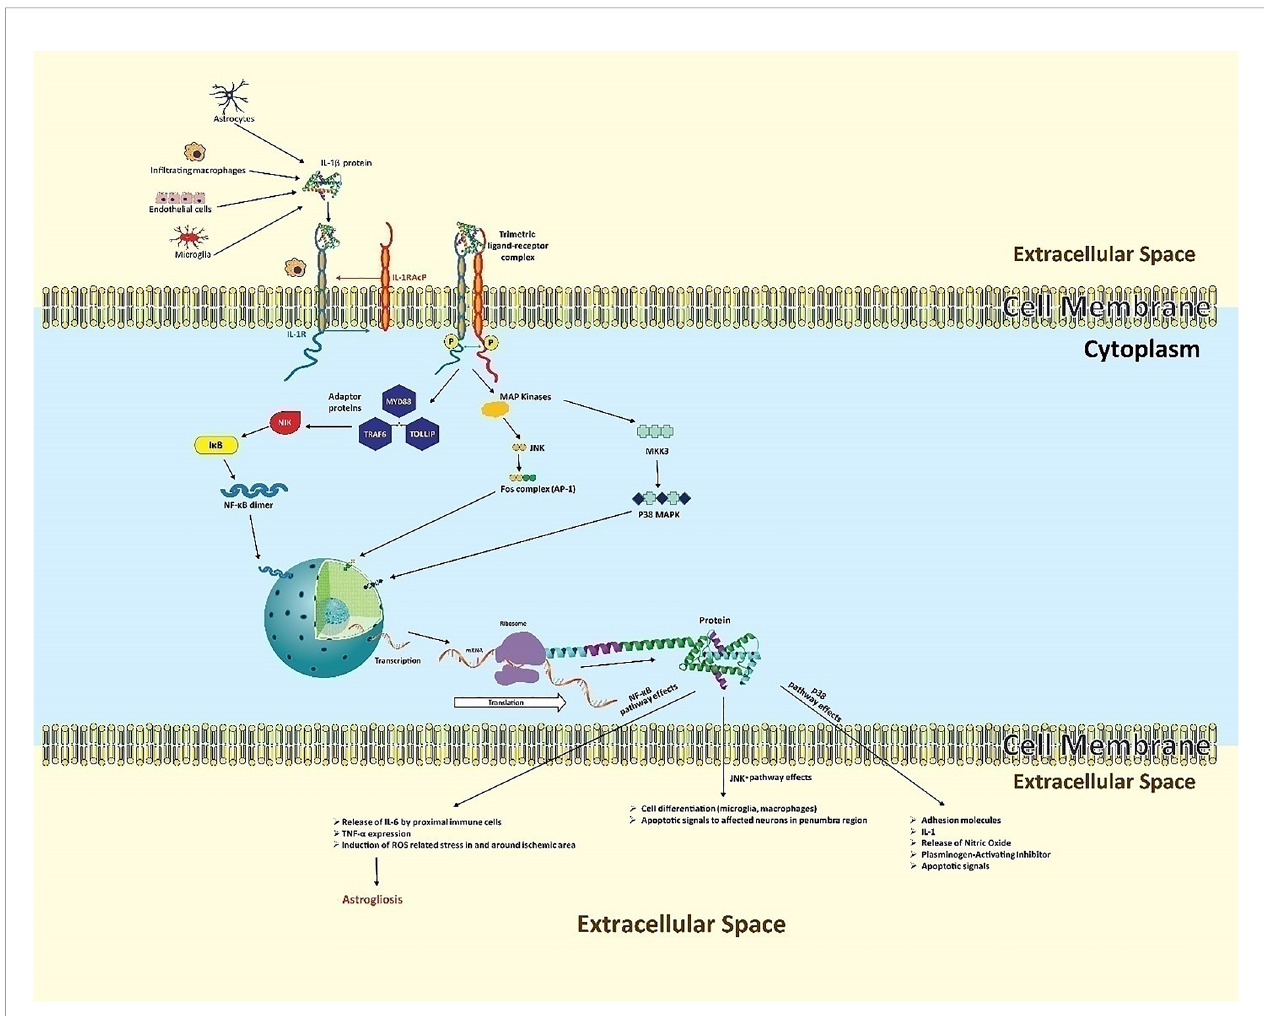
FIGURE 2 | The neuroin fl ammatory cascades of IL-1 b following ischemic insult. Secreted by microvascular endothelial cells, resident microglia, astrocytes, and in fi ltrating macrophages, IL-1 b forms a complex with IL-1R1, aided by IL-1RAcP. This ligand-receptor complex triggers three key neuroin fl ammatory mechanisms. In the NF- k B pathway, ligand-receptor binding results in the cytoplasmic recruitment of three key adaptor proteins: MYD88, TOLLIP, and TRAF6. This leads to the activation of intermediate kinases, particularly NIK, which prevent I k B from inactivating NF- k B, indirectly allowing NF- k B-dimer formation. These dimers of NF- k B function as transcriptional factors, entering the nucleus to induce transcription of IL-1, TNF, and many other genes in various cell types. In the JNK pathway, downstream of the “ death ” signal, intracellular MAPKs phosphorylate c-Jun or related proteins, which heterodimerize with Fos proteins to form the transcriptional factor activator protein (AP-1). AP-1 regulates gene expression that mediates pro-in fl ammatory cellular processes, particularly proliferation and differentiation of in fi ltrating immune lineage as well as apoptosis of regional neurons. In the p38 MAPK pathway, ligand binding activates intracellular MKKK3 which in turn activates p38-MAPK, causing expression of diverse apoptotic signals, adhesion molecules for in fi ltration, and